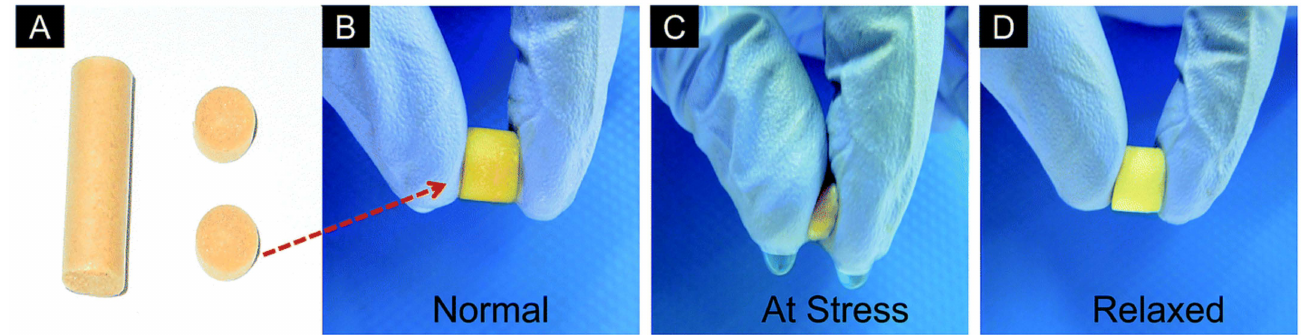
Figure 5. 3D biocomposite agarose–chitosan scaffold, ( A ) in various shapes, which displays sponge-like characteristic in ( B ) normal ( C ) at stress and ( D ) relaxed conditions. (Reproduced with permission from [55] under creative commons CC-BY license,